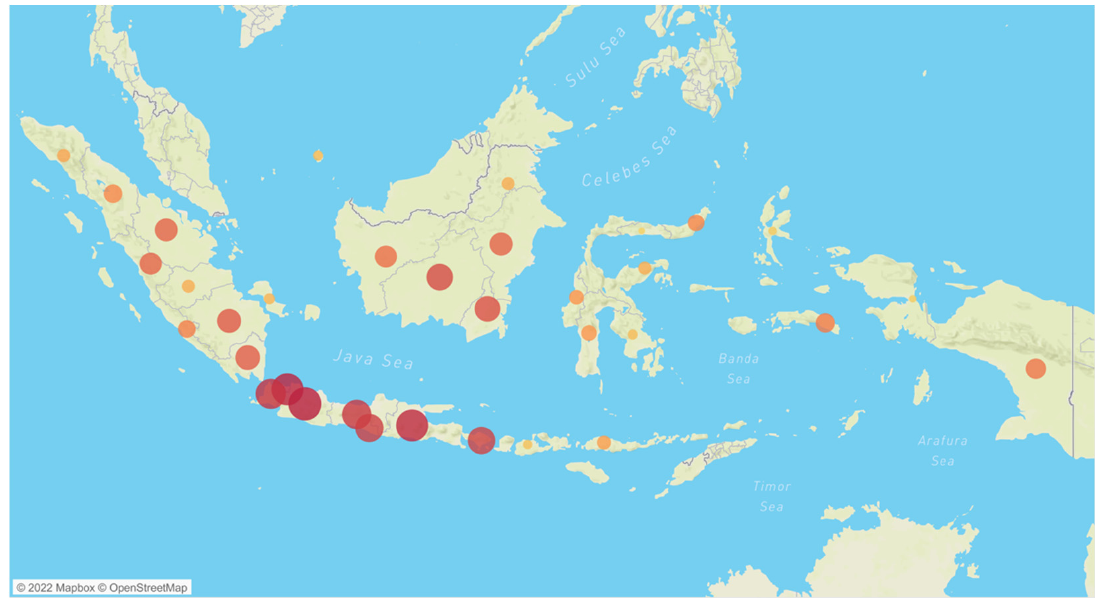
Figure 1. Geographic distribution of Indonesian health care workers responding to the COVID-19 vaccine intention survey ( n =